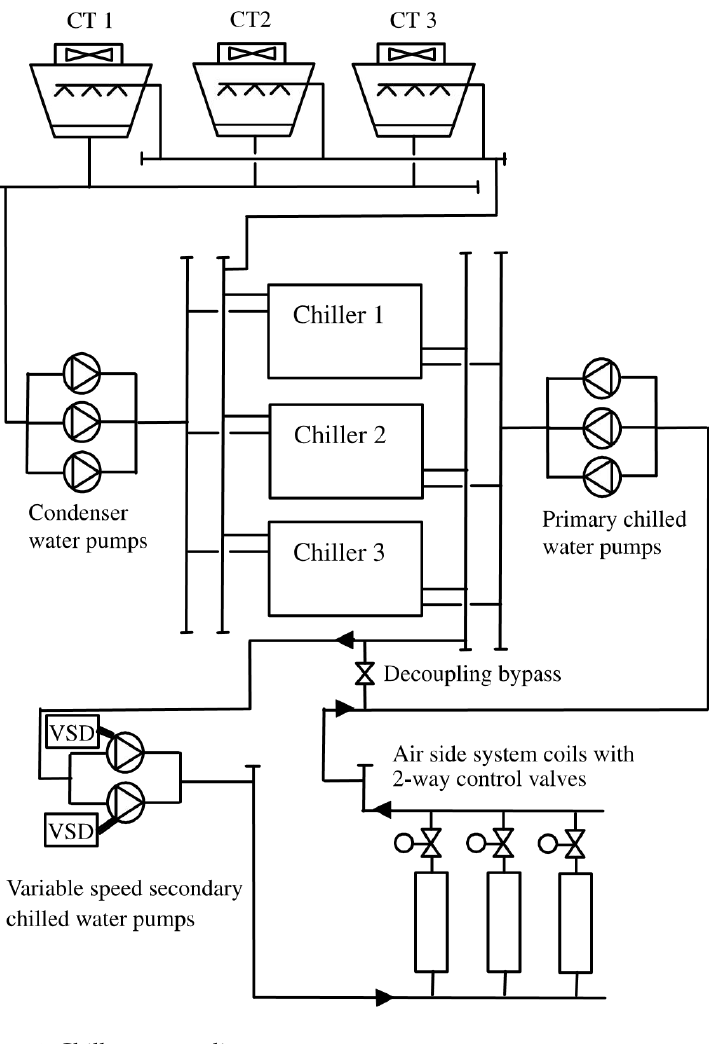
Figure 4. Chiller system